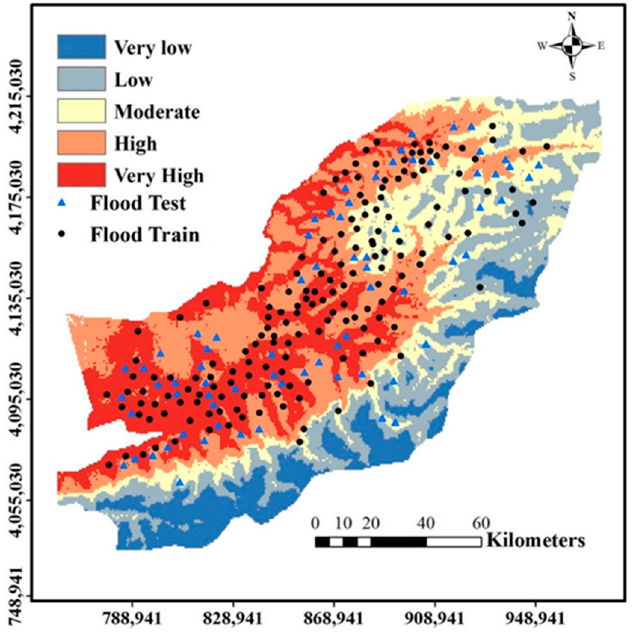
Figure 4. Flood zonation map of the study location (EDAS-FR-AHP model).